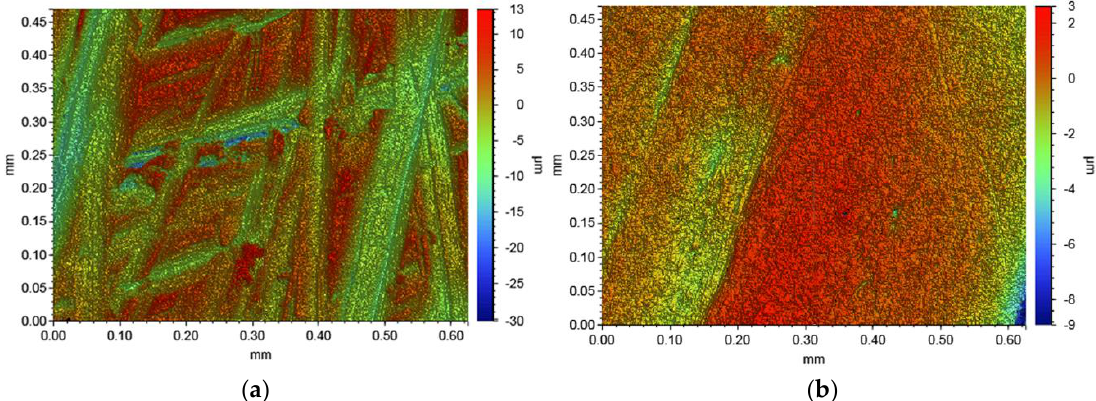
Figure 11. Three-dimensional topography of aluminum alloy (( a ) before polishing and ( b ) after polishing).